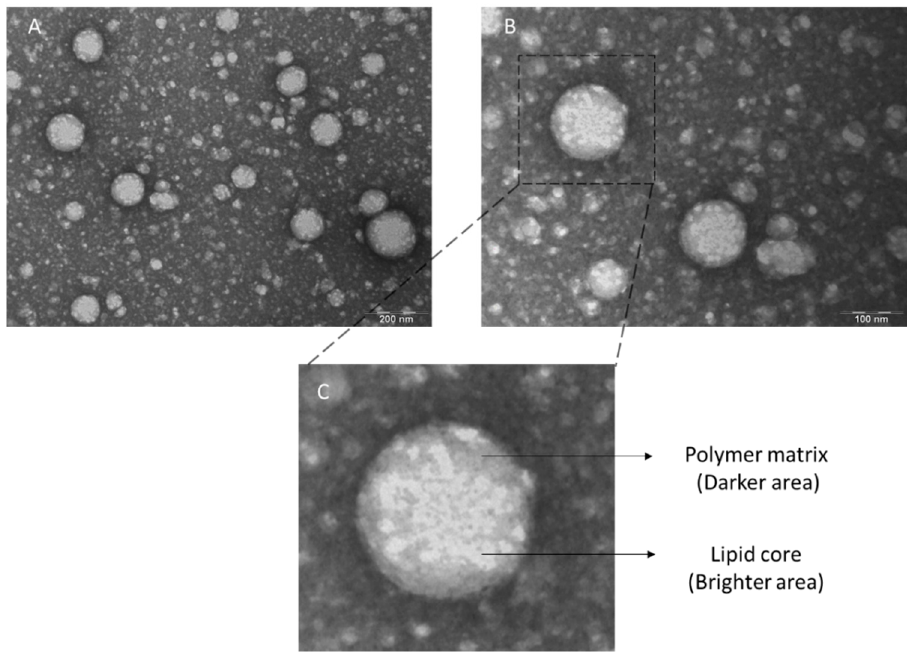
Figure 2. Transmission Electron Microscopy (TEM) images of negative-stained lipid–polymer hybrid LPNCs with 2% uranyl acetate at ( a ) ×250,000 magnification; and ( b ) ×300,000 magnification. ( c ) Individual nanoparticle representation zoom.